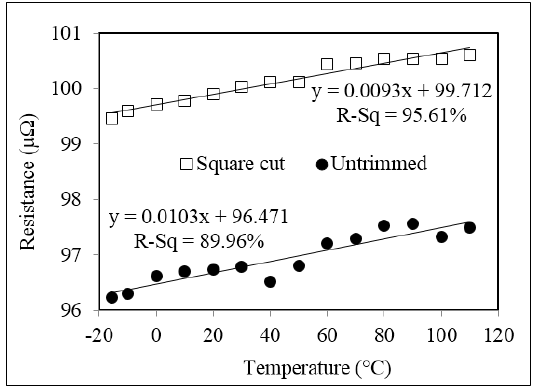
Figure 6. Resistance versus temperature for untrimmed and square cut trimmed shunt resistor samples.